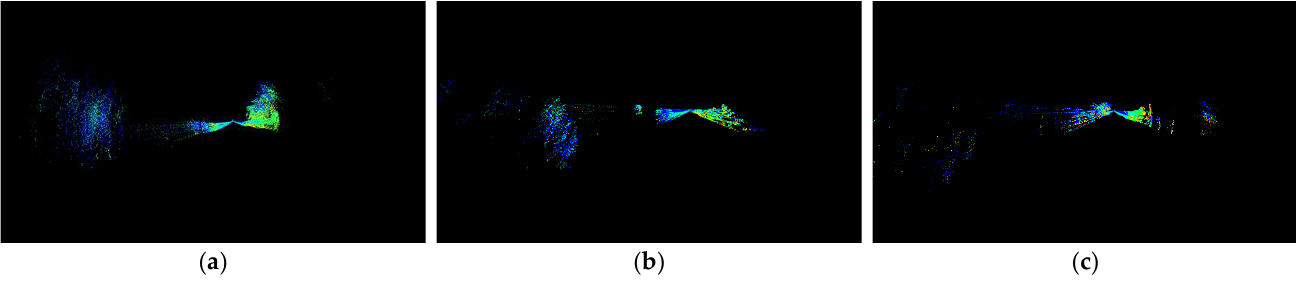
Figure 6. Point cloud image scene 2: Nottoway-Annex-track5-fast-1loop ( a ) Picture 1, ( b ) Picture 2, ( c ) Picture 3.